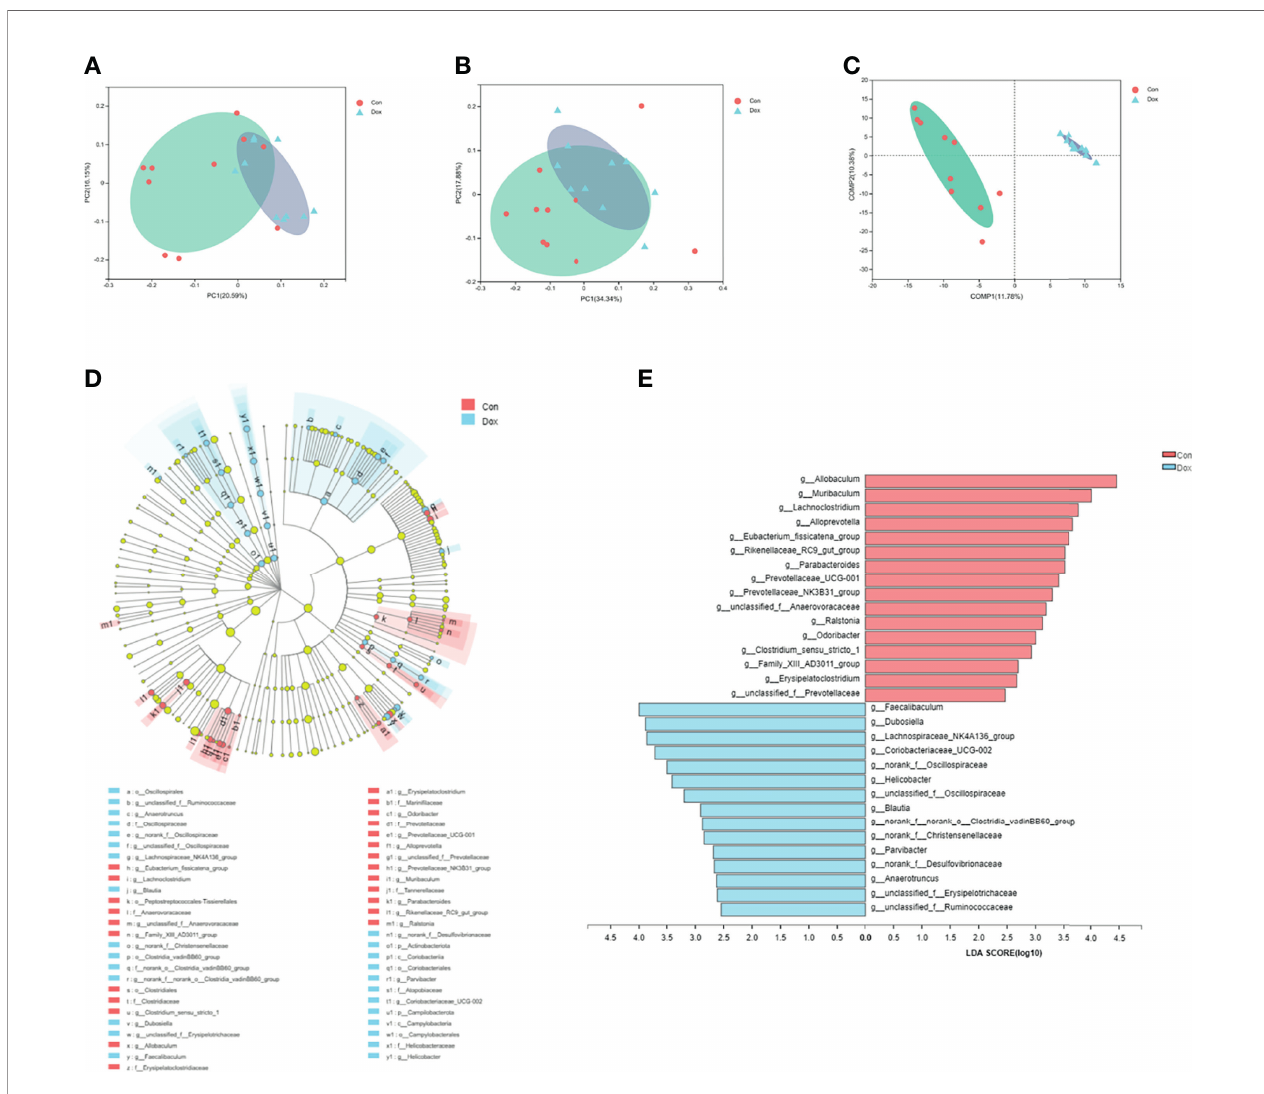
FIGURE 3 | Difference analysis of gut microbial composition between the two groups. (A, B) Principal coordinate analysis of unweighted (R = 0.3811, p = 0.001000) and weighted UniFrac (R = 0.2420, p = 0.004000) distances. PC1 and PC2 represent the top two principal coordinates that capture the maximum diversity. (C) Partial least squares discriminant analysis (PLS-DA). COMP 1 and COMP 2 represent the suspected in fl uencing factors for the deviation of the microbial composition. (D) Cladogram analyzed by LEfSe (LDA > 2.0, p < 0.05) showing the phylogenetic distribution of the bacterial lineages. Circles indicate phylogenetic levels from phylum to genus. Nodes with different colors indicate microbial taxa that are enriched in the corresponding groups and have signi fi cant differences between groups; yellow nodes indicate microbial taxa that have no signi fi cant differences between groups. The diameter of each node is proportional to the abundance of the group. (E) Histogram of LEfSe analysis (LDA > 2.0, p < 0.05) showing the LDA scores for differentially abundant genera. Con, control; Dox, doxorubicin; LDA, linear discriminant analysis; LEfSe, linear discriminant analysis effect size. n =